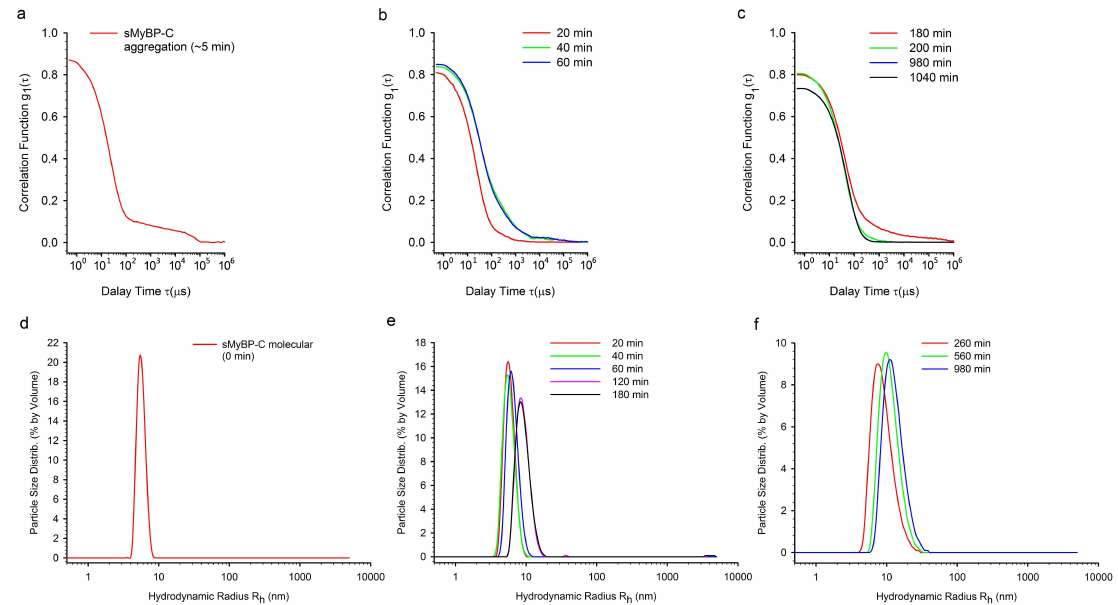
Figure 3. Kinetics of sMyBP-C aggregation monitored by DLS. ( a – c ) Evolution of field autocorrelation functions g 1 ( t ) of light scattered during sMyBP-C aggregate formation (pH 7.0–7.5, 10 ◦ C). ( d – f ) Distribution of sMyBP-C particles. Formation of large aggregates and their time-dependent growth are